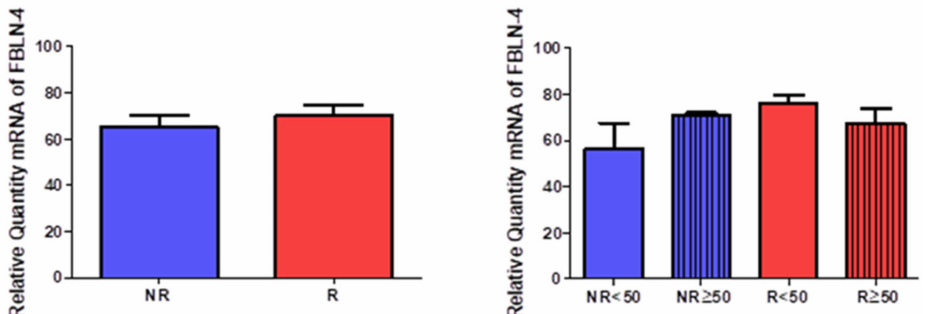
Figure 9. Expression levels of the gene for fibulin 4 quantified by RT-qPCR of patients without reflux (NR) and with reflux (R), as well as by their ages.